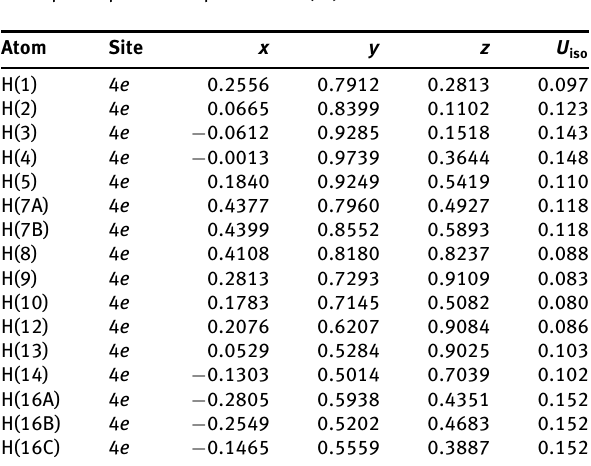
Table 2: Fractional atomic coordinates and isotropic or equivalent isotropic displacement parameters (Å 2